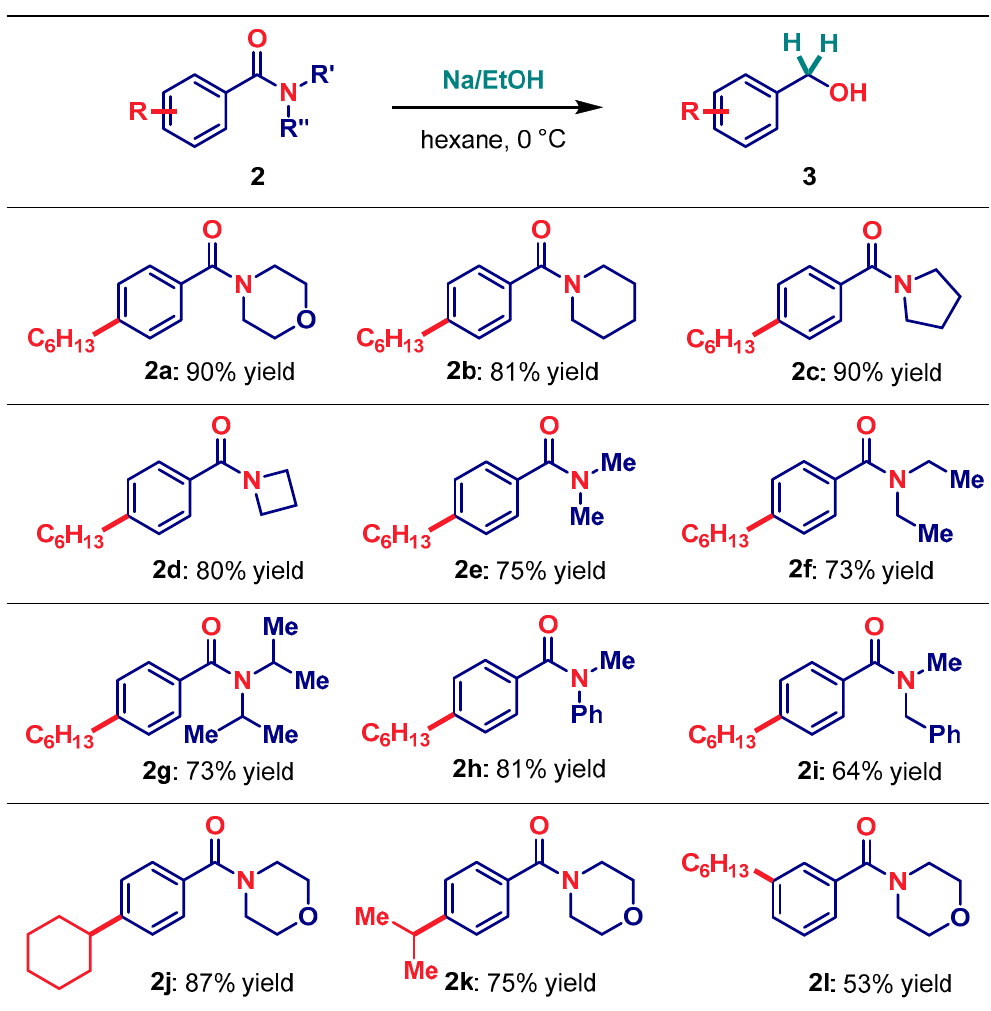
Table 4. Chemoselective Sodium Dispersion Mediated Reduction of Aromatic Amides to Benzyl Alcohols 1 .